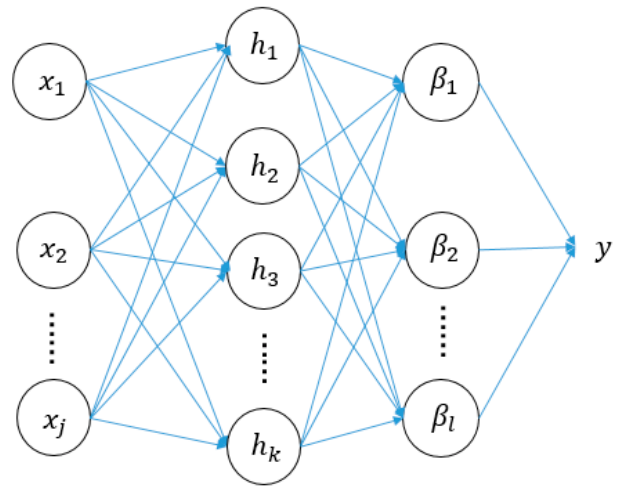
Figure 2. Structure of an extreme learning machine (ELM).